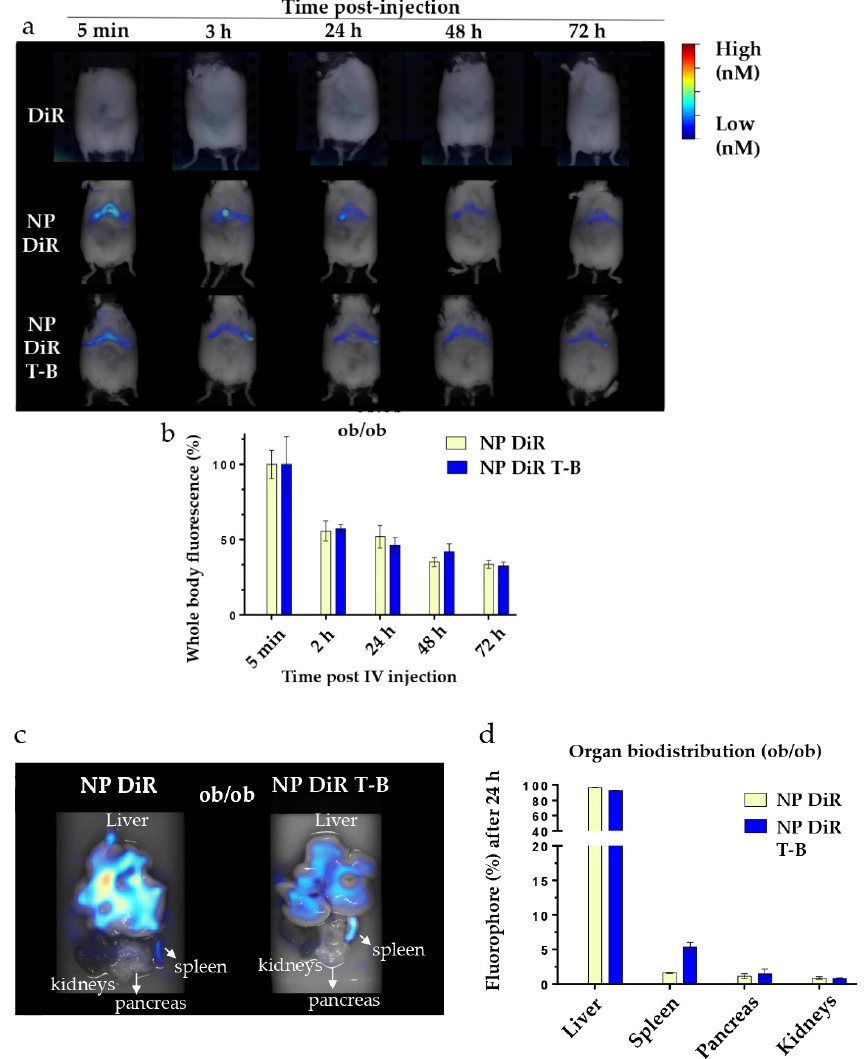
Figure 7. In vivo and organ DiR fluorescence imaging of genetically obese ob/ob mice following a single IV injection (120 µL) of soluble fluorophore or fluorescent particles (0.25% w/v ). ( a )